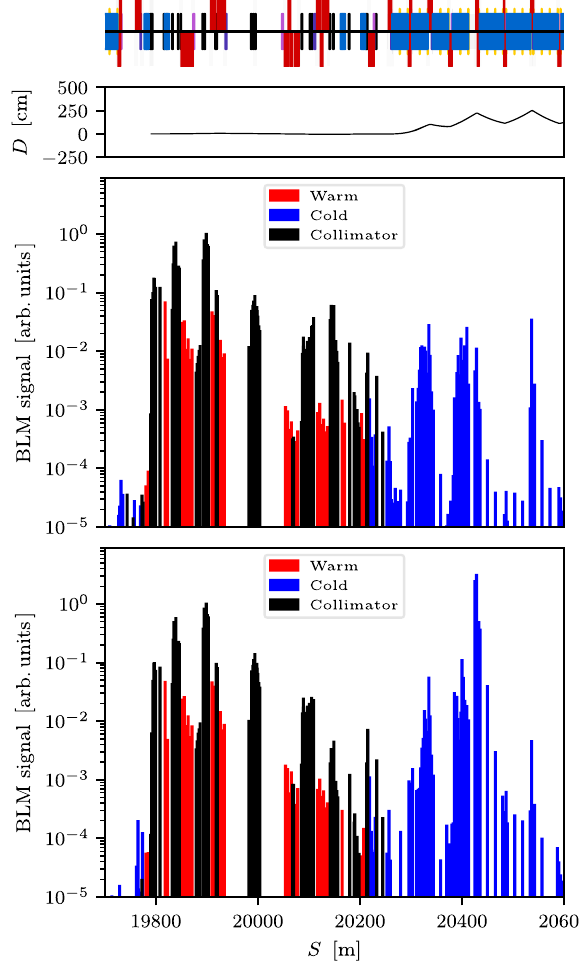
FIG. 3. Loss map for Beam 1 in the horizontal plane, recorded during the standard 208 Pb 82 þ fill (top) and during the experiments with 208 Pb 81 þ beams that were carried out in LHC in 2018 at top energy (bottom). The PSI case shows a visible excess of the BLM signal around S ¼ 20430 m. The machine lattice and the hori- zontal locally generated dispersion from the TCP are shown on the very top of the figure. The standard 208 Pb 82 þ fill featured total beam intensity of 1 . 4 × 10 11 ions while the experiments with 208 Pb 81 þ only featured 5 . 4 × 10 9